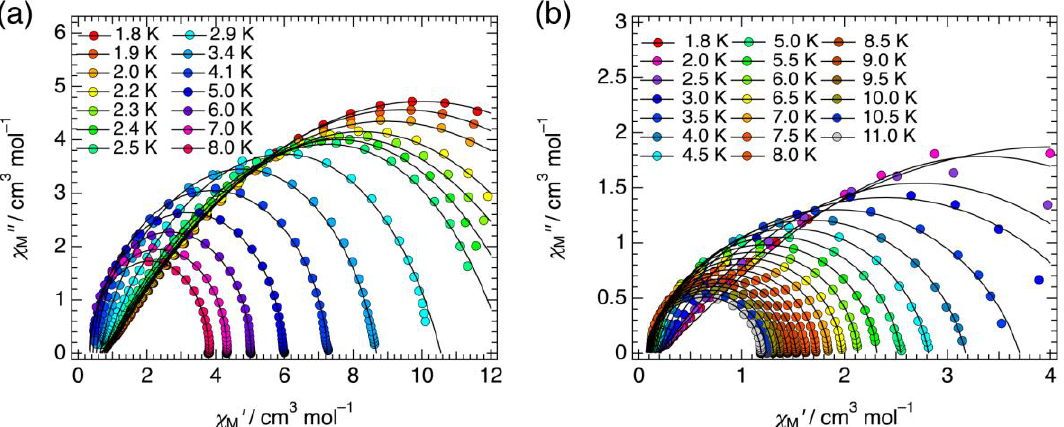
Figure 8. Argand plots at given temperatures in an applied DC field of 950 Oe for 1 ( a ) and 1500 Oe for 3 ( b ), respectively. Solid black lines are best-fit lines.